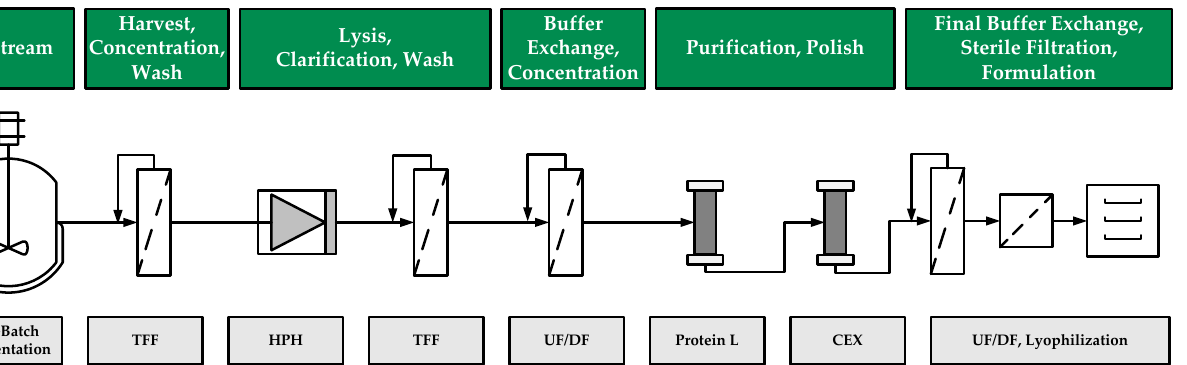
Figure 2. Workflow of model validation based on a QbD-oriented approach. In the first step, the QTPPs are defined. Subsequently, the CQAs are defined and a risk assessment of the influence of various process parameters on the CQAs is carried out. The risk assessment results in a design space for the process parameters to be investigated, which can be examined either via experiments or by means of a rigorous process model. Based on the results, a control strategy is defined, which can be continuously compared online via PAT with the actual state of the system. Strict implementation of this strategy allows continuous process optimization.